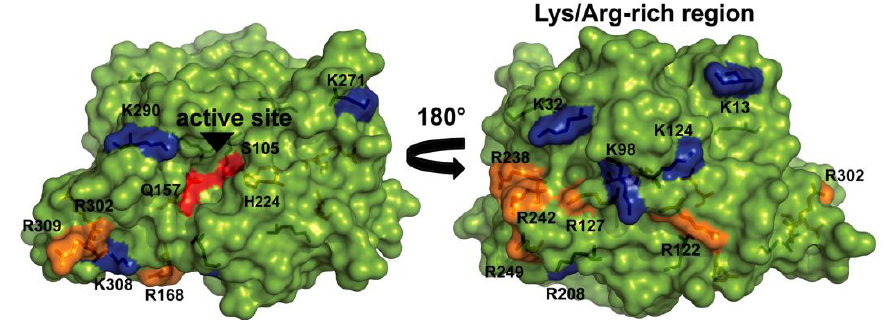
Figure 4. Surface representation of the crystal structure of CAL-B enzyme from Candida antartica (PDB ID: 4K6G) showing the location of the exposed lysines (in blue)/arginines (in orange) residues and the catalytic site (in red).